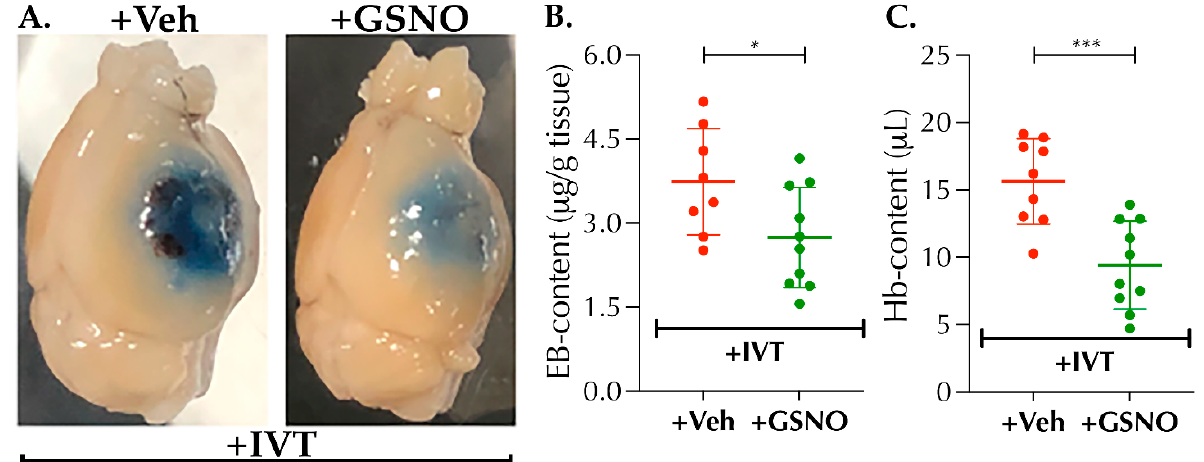
Figure 6. Nebulization of GSNO attenuates post ‐ thrombolysis blood–brain barrier (BBB) leakage and hemorrhagic trans ‐ formation (HT) in diabetic mice subjected to thrombotic stroke. Diabetic male mice (C57/B6 background, 14 ± 1 ‐ wks. old) were subjected to stroke, treated, and followed up to 24 h as described in Figure 5. ( A ) Representative images of the whole brain showing exacerbated EB/ BBB ‐ leakage and prominent HT in the Veh + IVT group in response to late ‐ IVT therapy at 3.5 h (5 ‐ mg/kgbwt), which was collectively reduced in the GSNO + IVT group. ( B ) Nebulization of GSNO (100 ‐μ g/kgbwt × 2 doses at 2 h and 6 h post ‐ stroke) in combination with late ‐ IVT (GSNO + IVT group) significantly reduced the BBB ‐ leakage as compared to late ‐ IVT alone (Veh + IVT group) controls (*, p = 0.0363, n = 8–10 mice/group). (C) Moreover, HT also was significantly attenuated in the GSNO + IVT group as compared to the Veh + IVT controls (***, p = 0.0006, n = 9–10 mice/group). Statistical significance was determined at p < 0.05 and using an unpaired t ‐ test . No mortalities were observed in both sets of GSNO + IVT group; however, Veh + IVT group showed overall 3 mortalities out of 20 mice likely due to late IVT ‐ therapy and the resulting significant HT in Veh + IVT group.